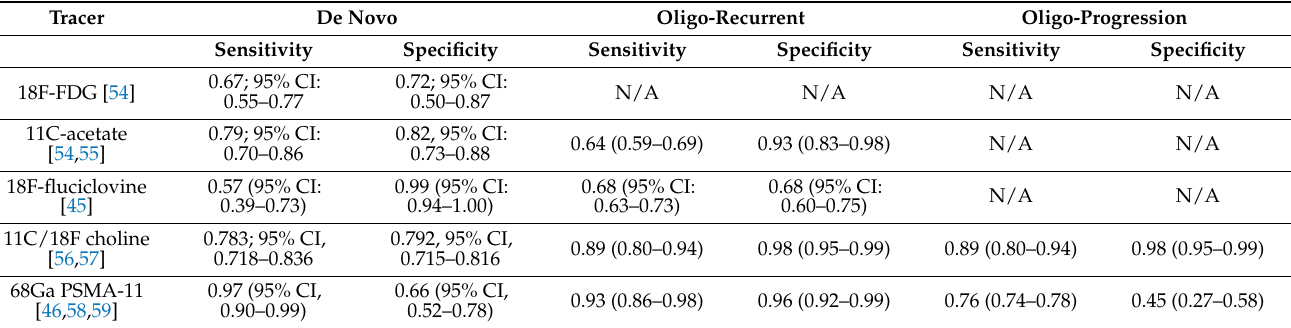
Table 3. Overall detection rates of different PET–CT tracers in oligometastatic prostate cancer in different